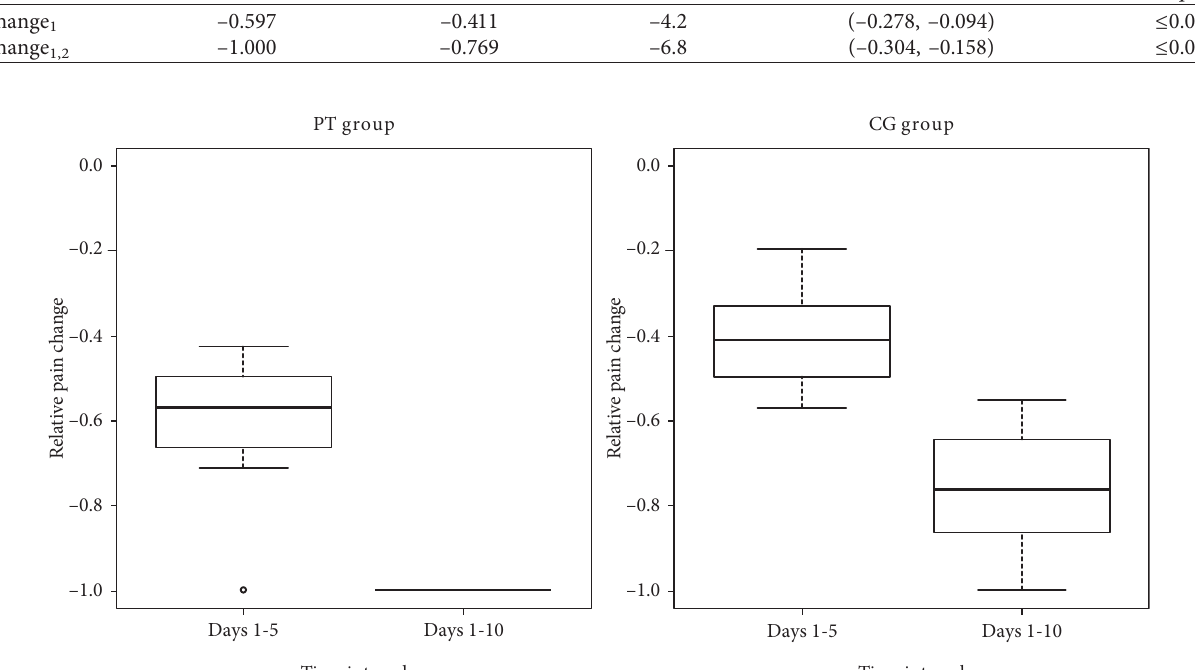
Figure 4: Distribution of relative changes in pain intensity in the PT and CG (lower � greater pain